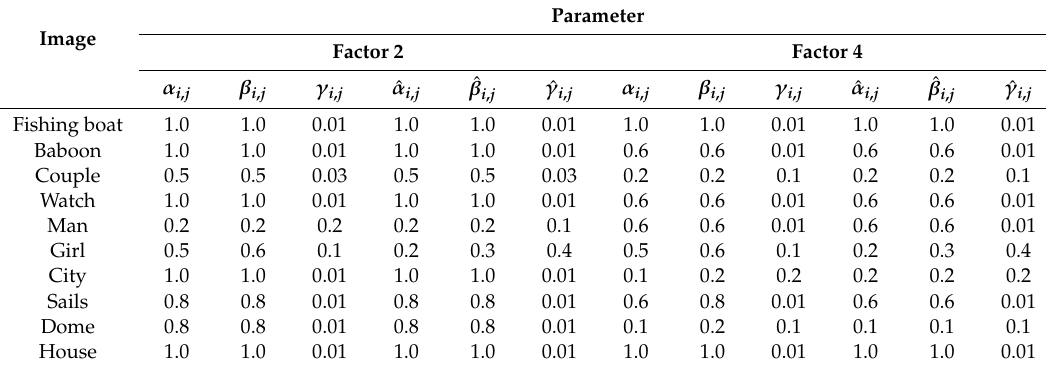
Table 7. Parameter value for image